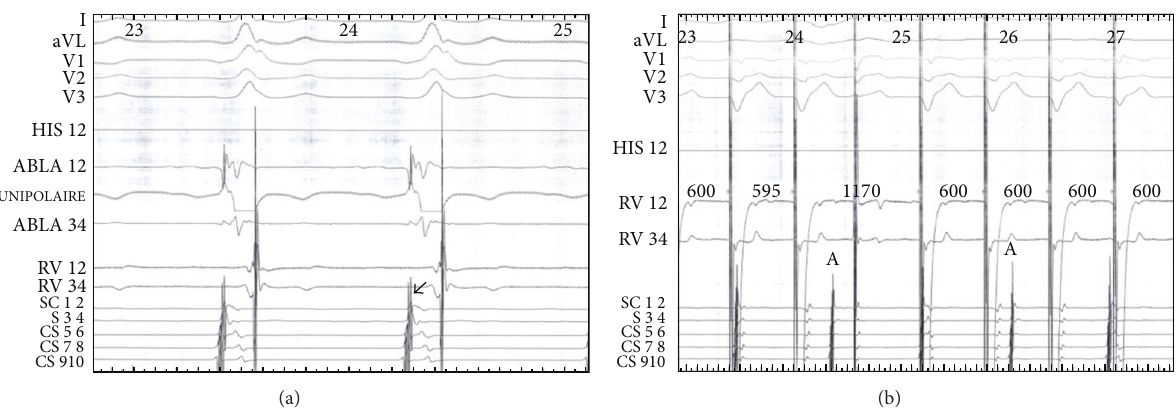
Figure 3: The electrophysiology study showed a shorter AV at the distal electrode of decapolar (a) with dissociation atrioventricular conduction in retrograde (b). This figure confirmed the diagnosis of a left accessory bypass with only anterograde conduction.